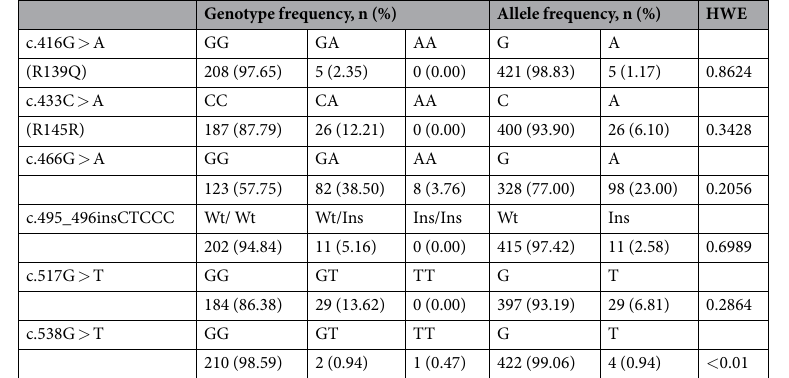
Table 1. Genotype and allele frequencies of SPRN polymorphisms in Korean native black goats.